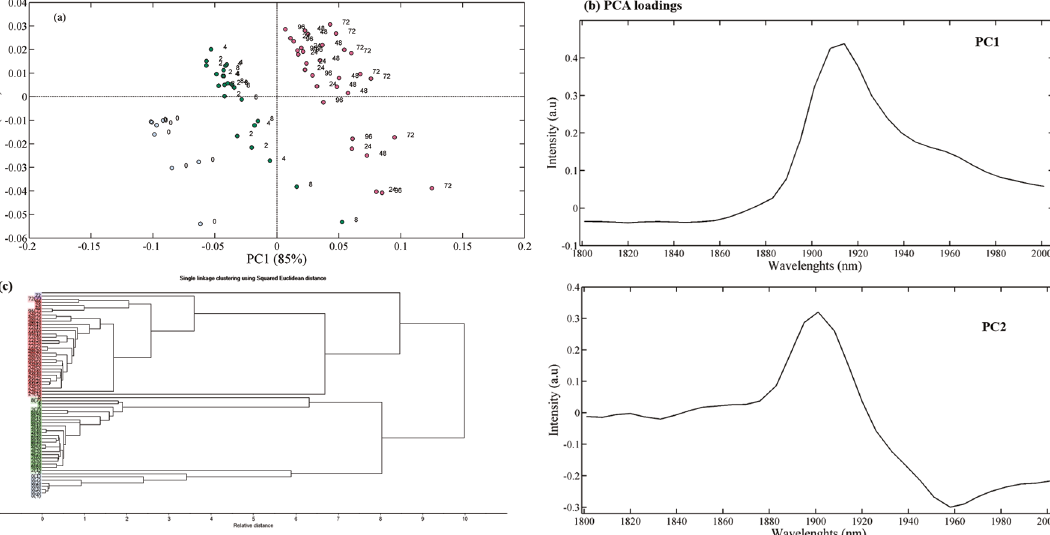
Figure 8. Exploratory analysis performed in the NIR spectra of PET samples exposed to NaOH during exposure time (a) Scores of PC1 versus PC2, (b) loadings for PC1 and PC2, (c) dendrogram of the